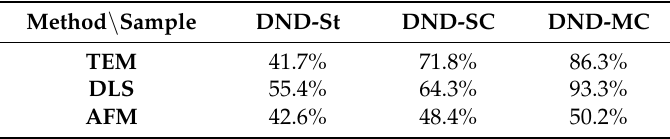
Table 1. Percentage of DND particles with sizes less than 4